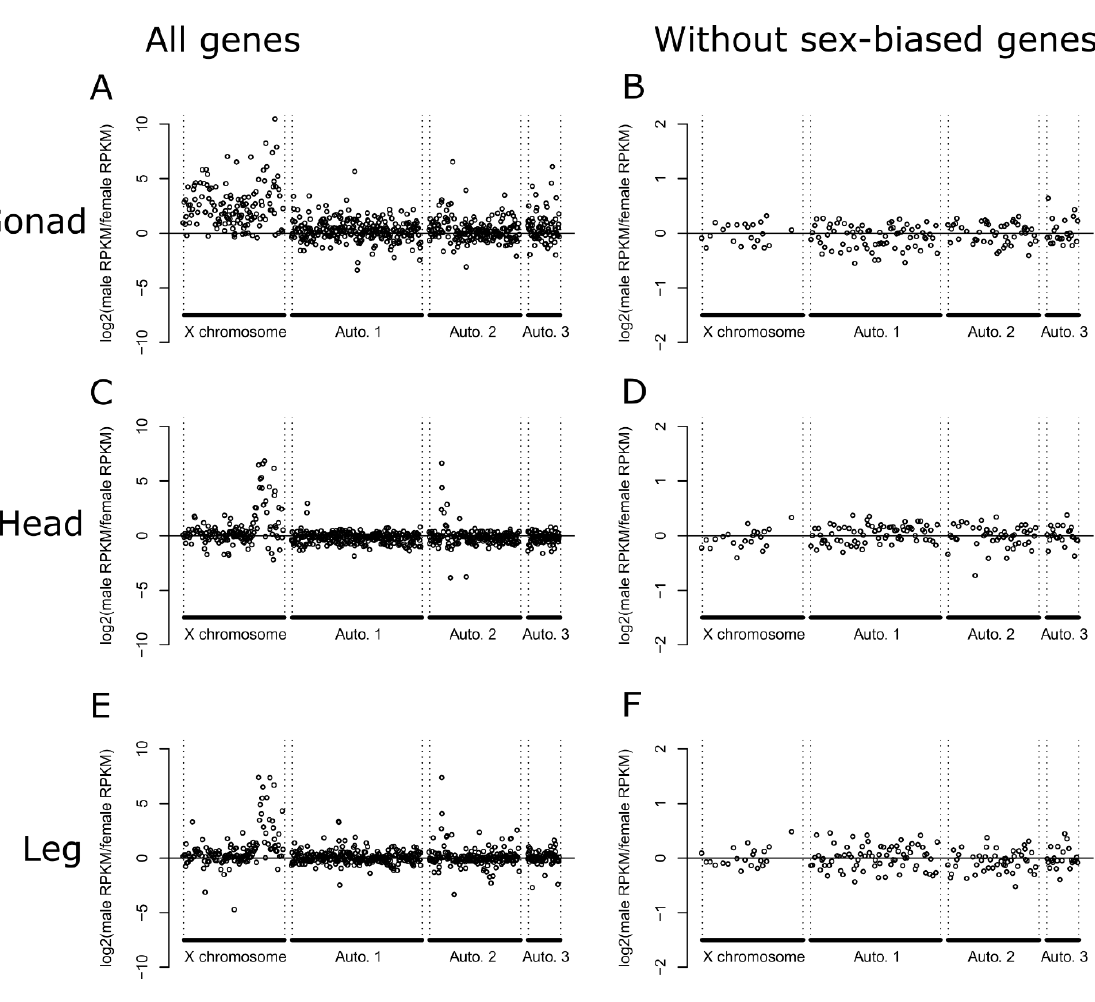
Supplementary figure S6 : Logarithm of male to sexual female ratio of expression (in RPKM) along chromosomes in gonads (panels A and B), heads (C and D) and legs (E and F). In panels A, C and E, all expressed genes were included, while only genes with a less than 2-fold change in expression between males and sexual females within each of the tissues were retained in panels B, D and E (i.e. sex-biased genes were removed). To mitigate the high inter-gene variation, which could mask a pattern, we made sliding averages over 20 genes along the chromosomes (i.e. each point is the average over 20